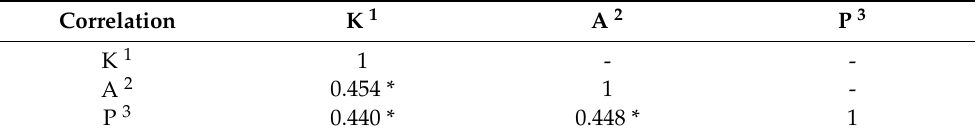
Table 5. Correlations among knowledge, attitude, and practice associated with medication safety ( n = 131).